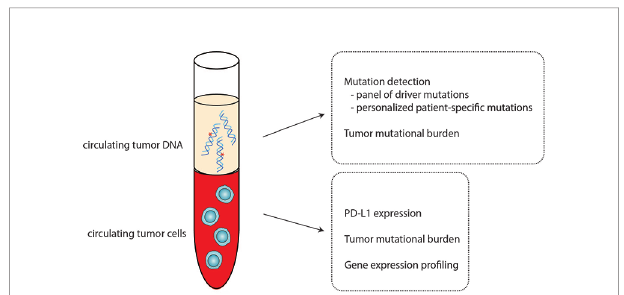
FIGURE 1 | Circulating tumor cells (CTCs) and circulating tumor DNA (ctDNA) as biomarkers for immunotherapy. CTCs and ctDNA can serve as